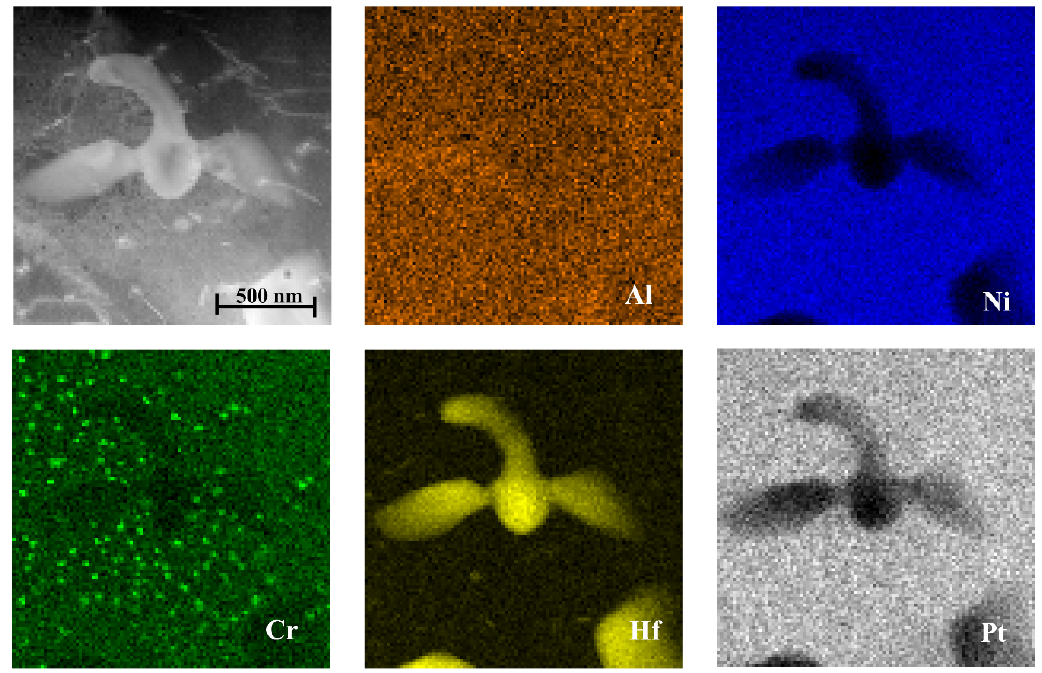
Figure 7. STEM HAADF image of the additive layer with corresponding maps presenting distribution of Al, Ni, Cr, Hf, Pt (Run II). Materials 2018 , 11 , x FOR PEER REVIEW